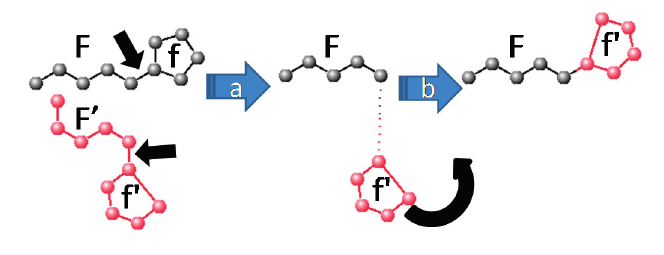
Figure 1. Principle of fragment